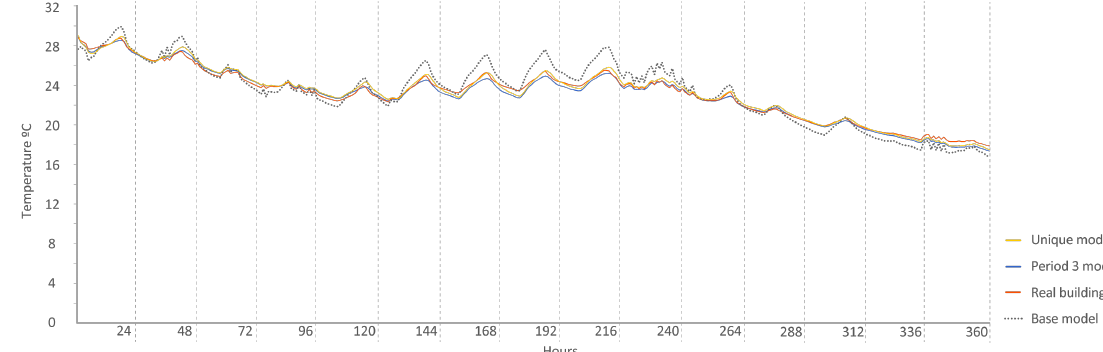
Figure 17. Temperature in house N2, Period 3 (ROLBS). Period 3 model: CV(RMSE): 1.24%, NMBE: 0.49%, and R 2 : 99.09%. Base model: CV(RMSE): 3.71%, NMBE: − 0.93%, and R 2 : 95.45%. Unique model: CV(RMSE): 1.23%, NMBE: − 0.38%, and R 2 :